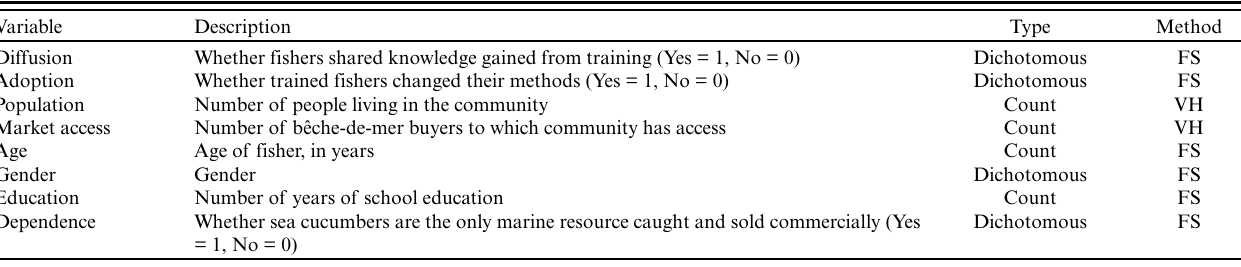
Table 1 . Descriptions of the dependent variables (knowledge sharing and adoption) and independent variables (individual- and community-scale characteristics) used to explore adoption and diffusion of methods promoted in a training program on postharvest processing of sea cucumbers. FS = fisher surveys; VH = village headmen